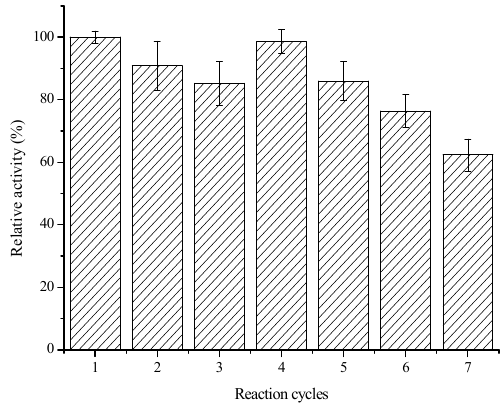
Figure 7. Reusability of the immobilized COX-2 ( n = 3).